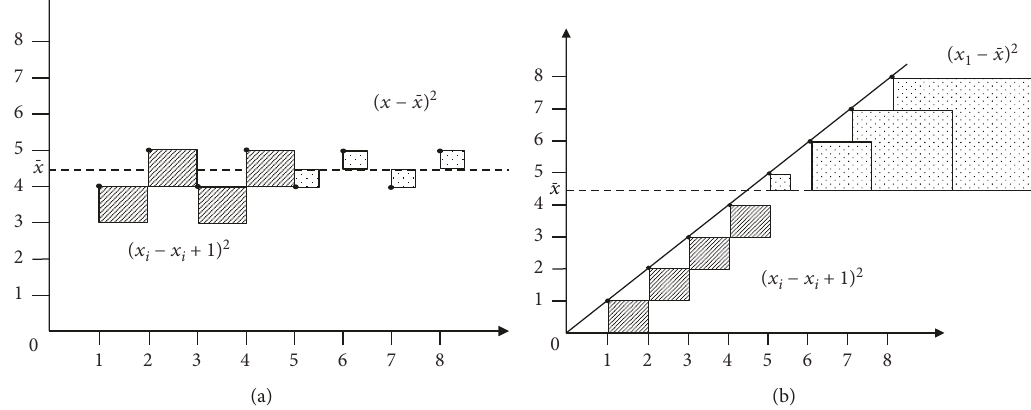
Figure 3: Graphical representation of the squared di ff erence between (i) each data point and its subsequent value in the series (lined squares) and (ii) each data point and the average of the series (dotted squares) in the case of an oriented trend (a) and in the case of stationary data (b).